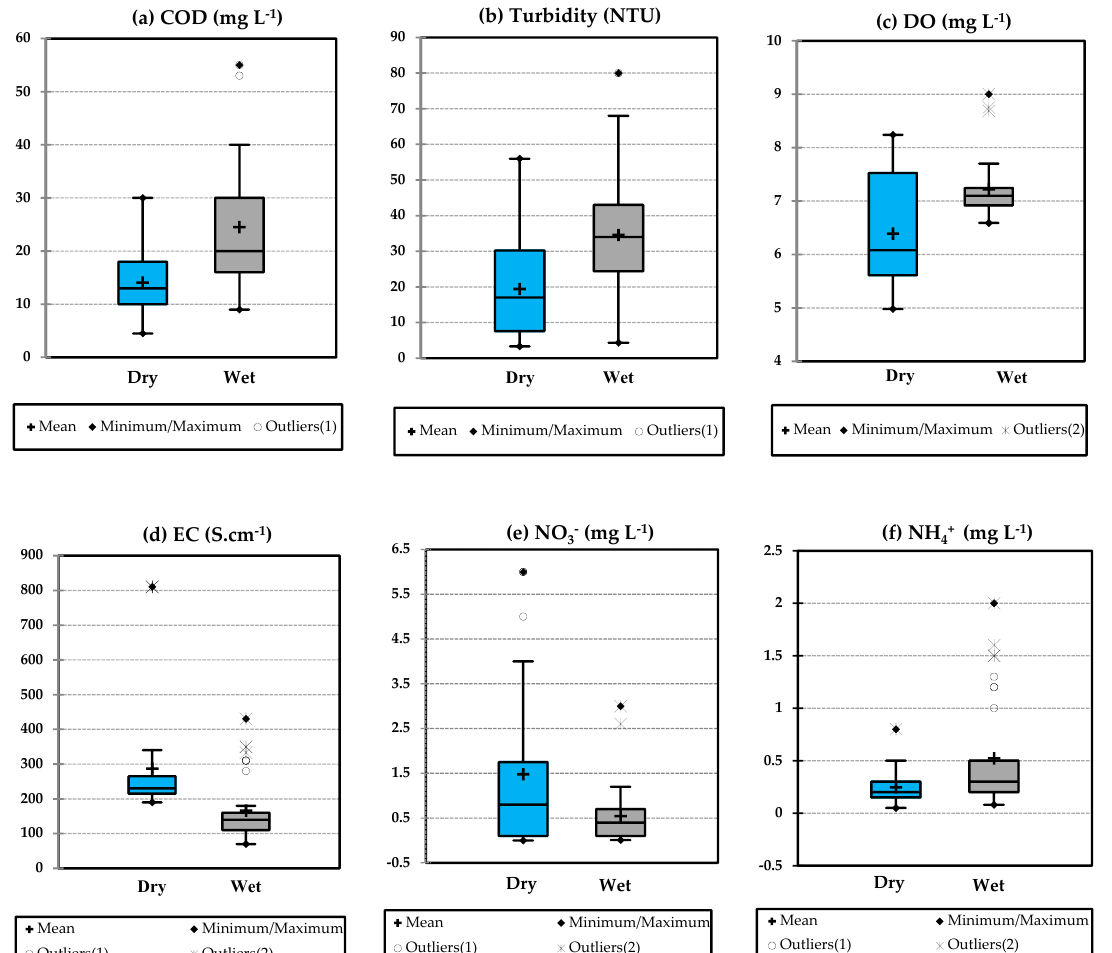
Figure 3. Summary data of discriminant parameters in the dry and the wet seasons: ( a ) COD, ( b ) turbidity, ( c ) DO, ( d ) EC, ( e ) NO 3 − , and ( f ) NH 4 + in surface water quality. The outliers of NH 4 + and EC in the wet season were found inside full-dike systems (c7, f1, f3, f6, f9, and f14). Note: R: river, c: primary canal, f: field canal; 1: inside full-dike, 2: inside semi-dike, 3: outside of dike.